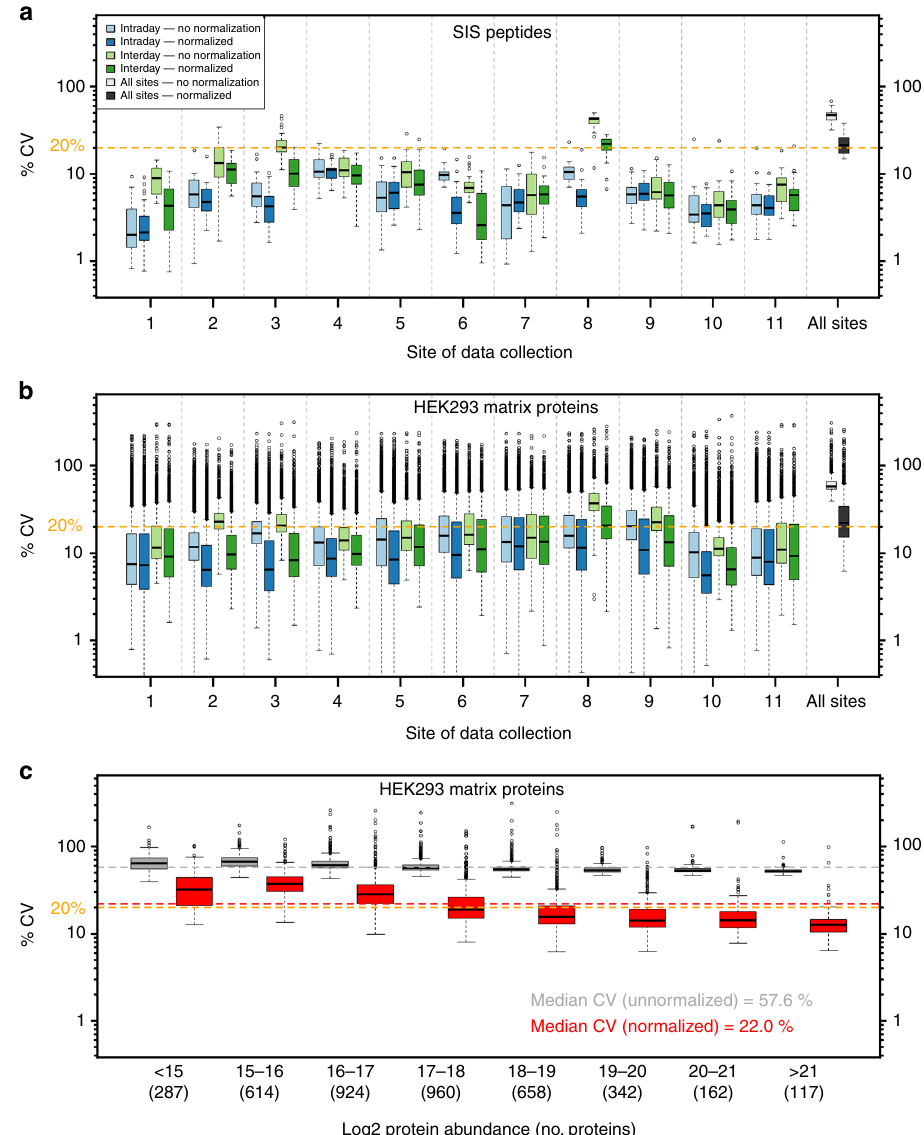
Fig. 3 Reproducibility of SWATH-MS measurements. a The CVs of peak areas for each of the 30 SIS peptides for S4 sample, depicted on the y -axis using logarithmic scaling, were determined at the intra-day level within the site ( light blue — without normalization, dark blue with normalization), inter-day level within site ( light green — without normalization, dark green with normalization), and inter-site level (i.e., over all S4 samples in the study; light gray — without normalization, dark gray — with normalization). The orange line indicates 20% CV for visual reference. b Similarly, the CV of protein abundances for the 4077 proteins that were detected in > 80% all samples were computed at the intra-day level within the site, inter-day with site, and inter-site (i.e., all 229 samples in the study). c The inter-site CVs were binned based on log2 protein abundance to visualize the dependence of CV on protein